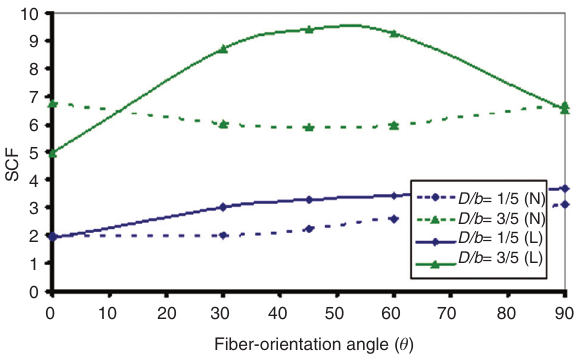
Figure 11 Effect of fiber orientation angle ( θ ) on SCF for a / b = 1 using boron/epoxy material.